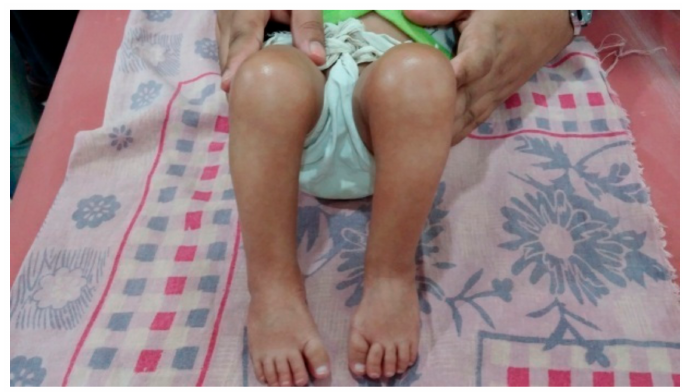
Figure 4. ( a – d ) Subsequent steps in manipulation and casting (casts 2–4).